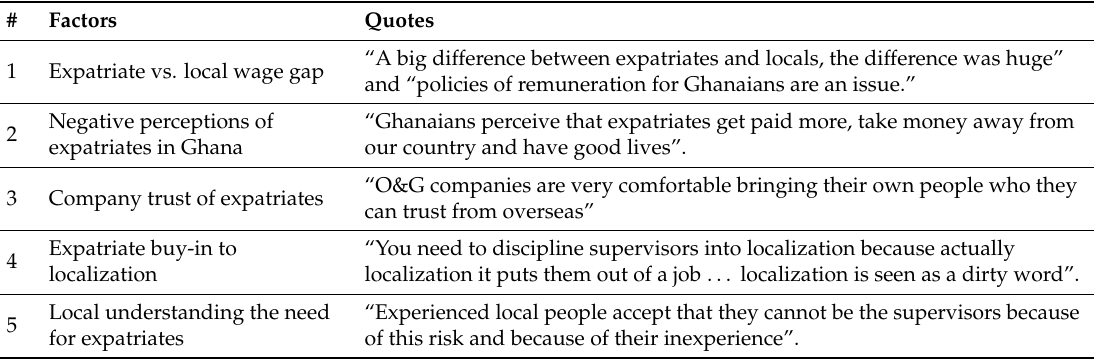
Table 8. ‘Expatriate employees’